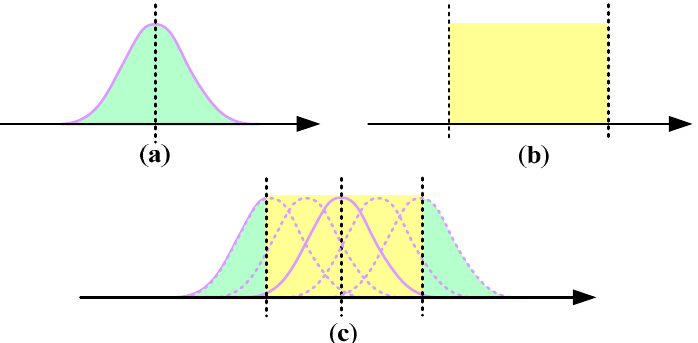
Figure 1. The model with dual uncertainties can be regarded as a set of Gaussian densities (e.g., the dual-noise acceleration model): ( a ) Stochastic model ( w ); ( b ) set-membership model ( d ); ( c ) dual uncertainties model ( ω ).